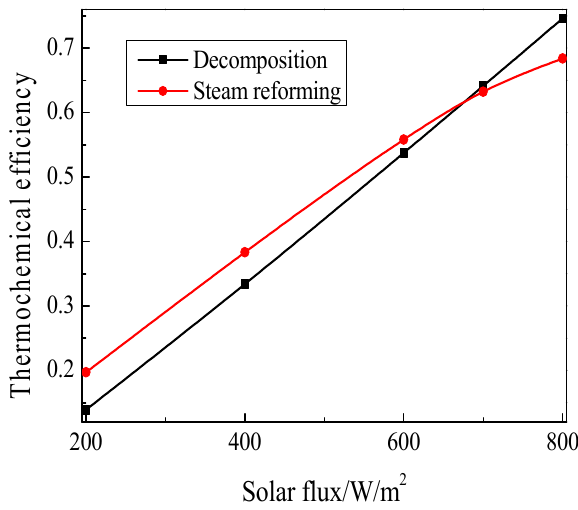
Figure 7. Thermochemical efficiency variation with solar flux for steam reforming and methanol Fig. 7.Variation of thermochemical efficiency with solar flux for steam reforming and methanol 260